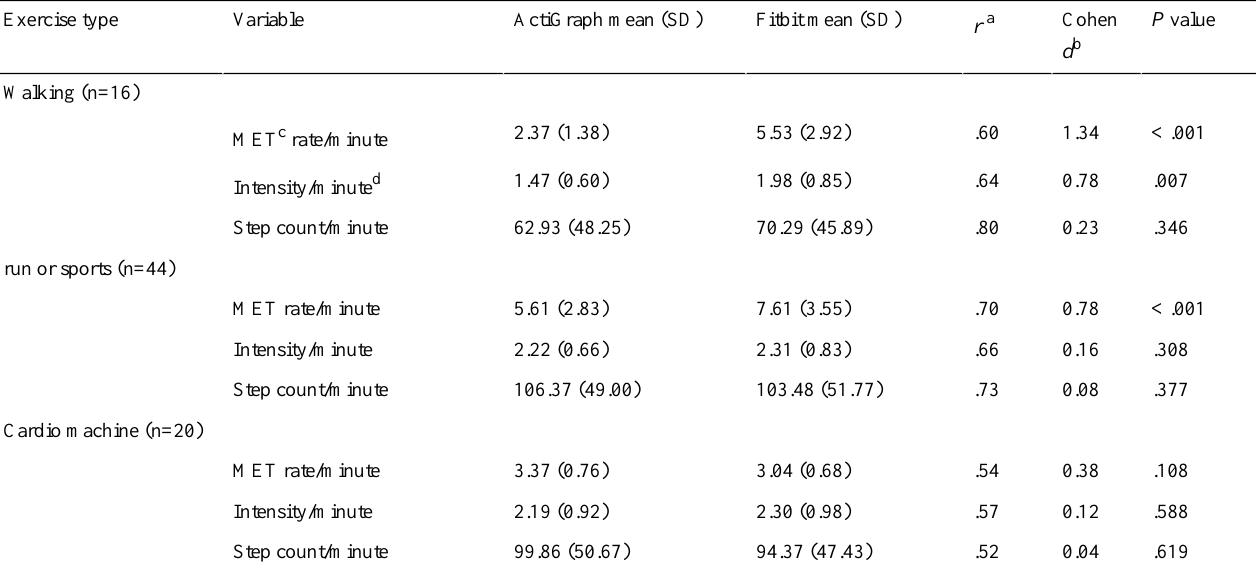
Table 4. Minute-level measurement differences for activity variables by exercise type and